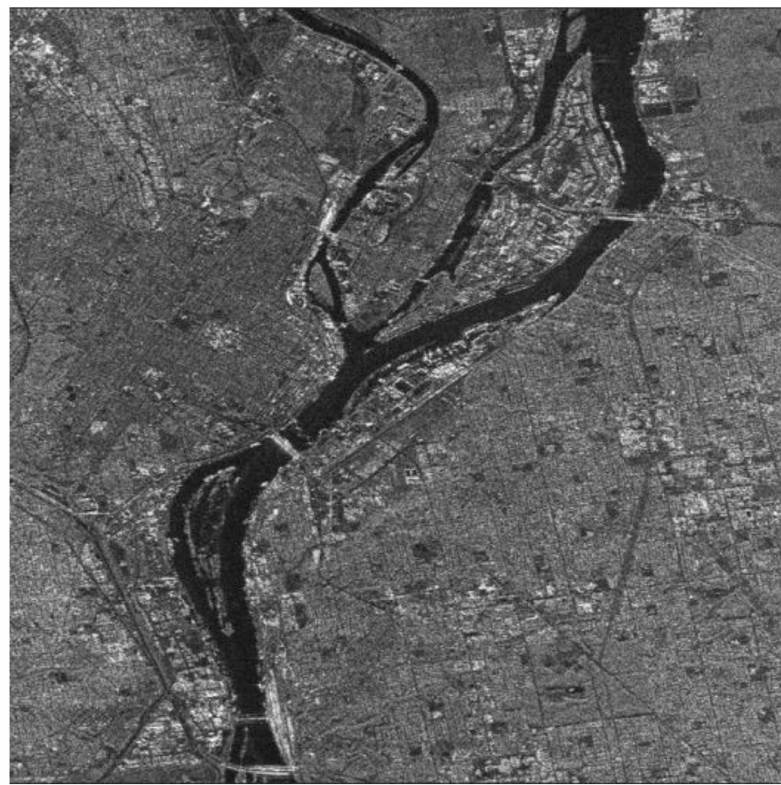
Figure 5. Original SAR image. Table 2. Evaluation metrics for the three methods in the case of different SINR.